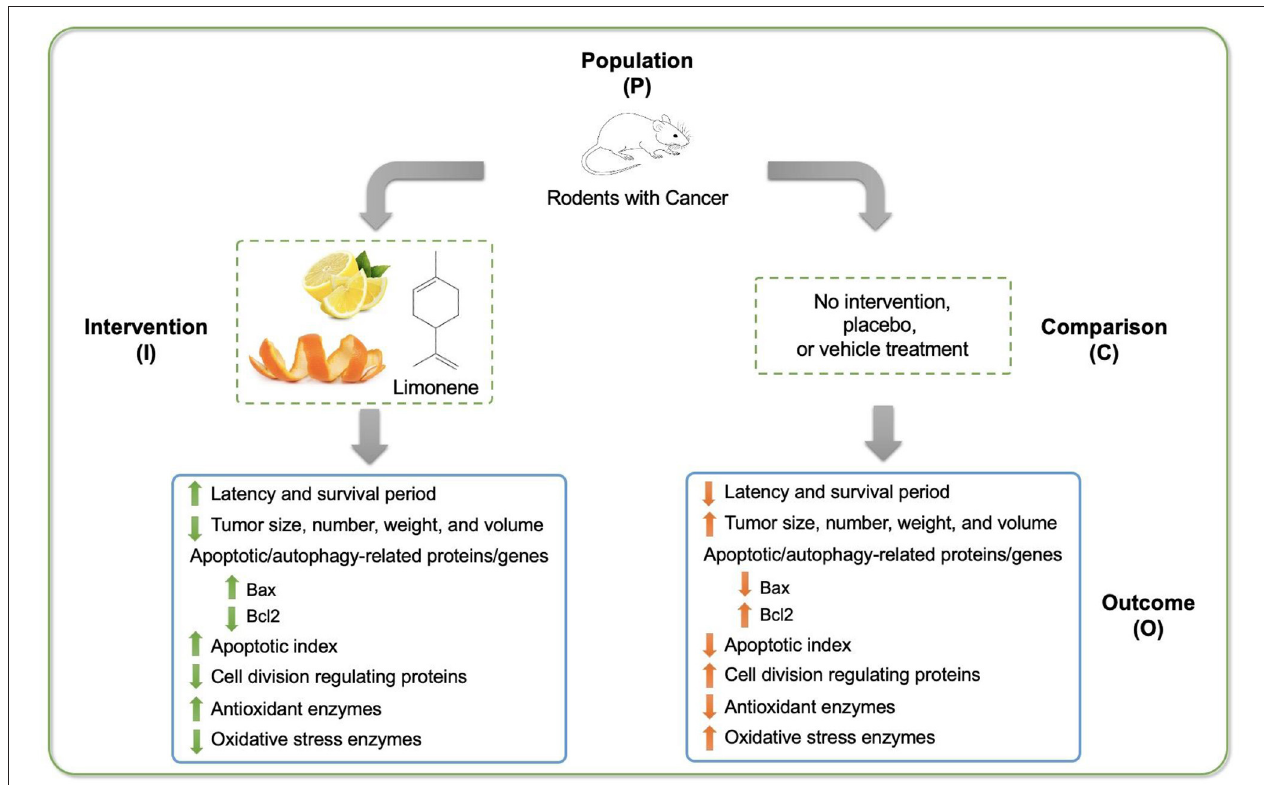
FIGURE 2 | Schematic diagram of major findings from the research evaluating the effect of limonene on cancer development in rodent models.